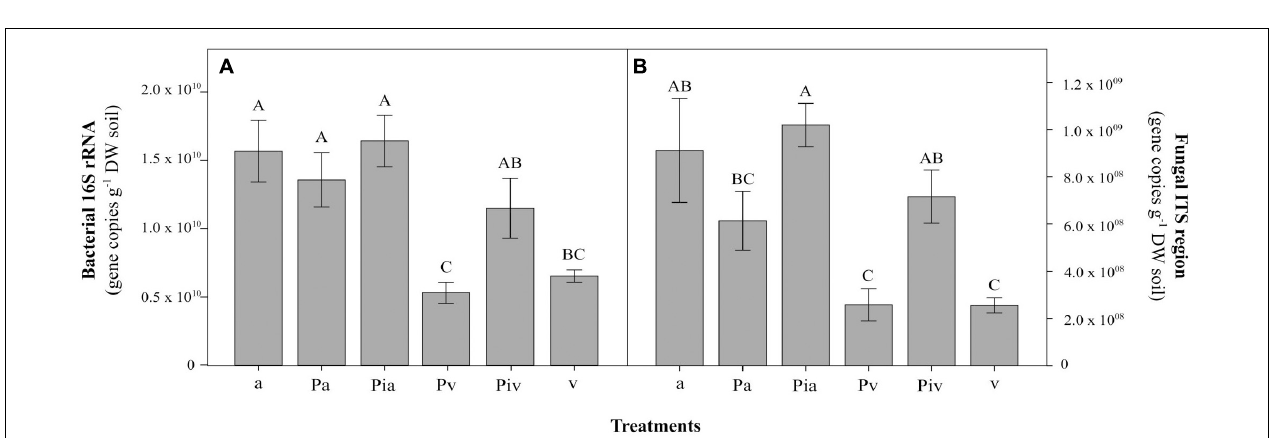
FIGURE 5 | Bacterial (A) and fungal (B) gene copy abundances at the end of the experiment (2018, t f ). Treatments: a, planting of alfalfa; Pa, intercropping of non-mycorrhizal poplars with alfalfa; Pia, intercropping of mycorrhizal poplars with alfalfa; Pv, planting of non-mycorrhizal poplars with spontaneous vegetation; Piv, planting of mycorrhizal poplars with spontaneous vegetation; v, spontaneous vegetation (unplanted control). Capital letters indicate significant differences between treatments according to one-way ANOVA and Duncan’s MRT ( p < 0.05). Each bar represents the mean ± SE ( n = 3).